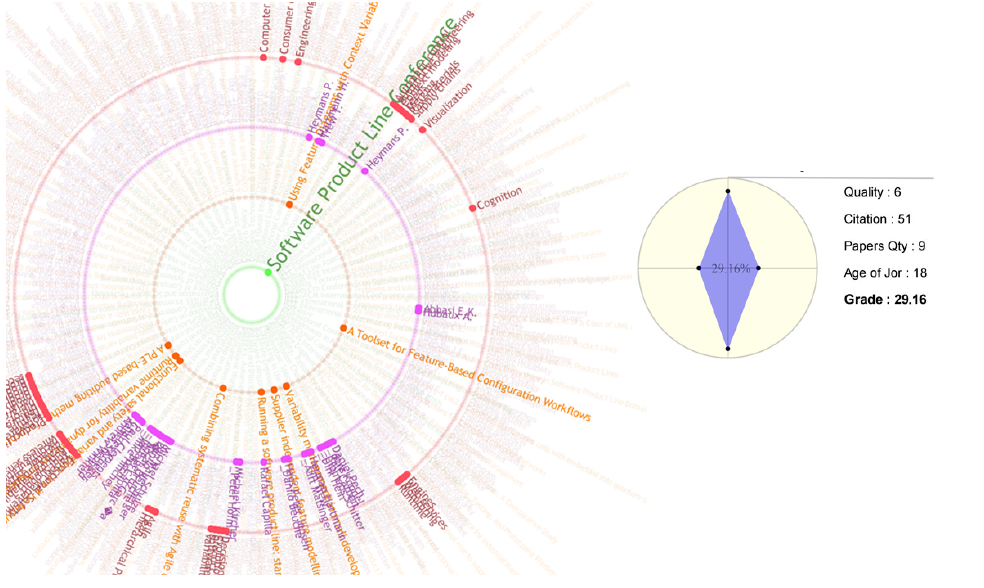
Figure 15. A journal has been selected.